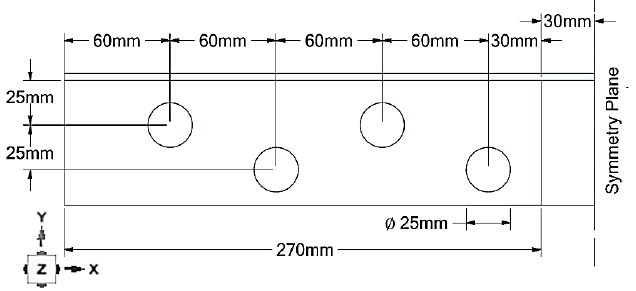
Figure 7. Front view of the perforated breakwater (half of the length about the symmetry plane).